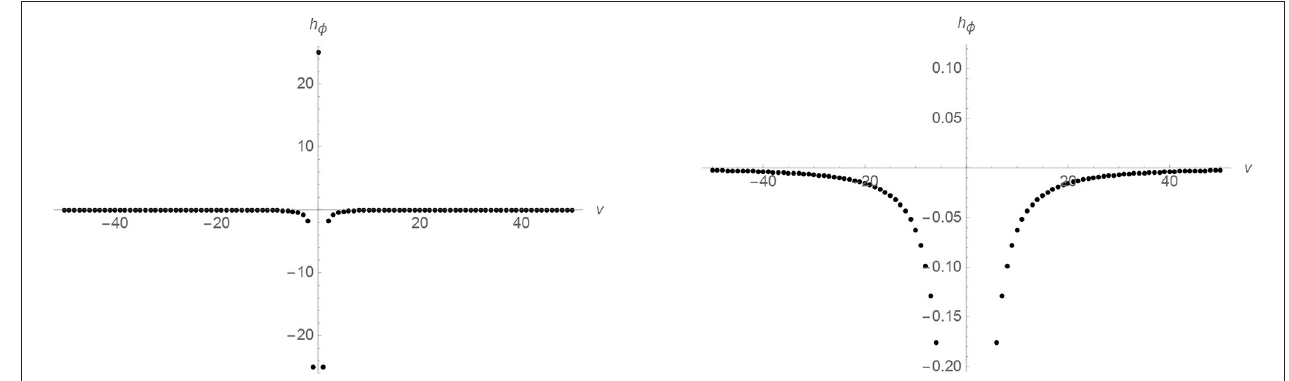
λ ) evaluated on an ǫ sector containing ν FIGURE 3 | The function h φ ( ν 0, for p φ 10 in natural units and λ 1 / 2 is plotted using two different ranges. On the left, ; = = = ν − 2 for large values of ν . This function can be seen as the effective potential we see that the function is finite near ν 0. On the right, we can see that it behaves like = − where an asymptotically free state of the universe (pure gravity with cosmological constant state or asymptotically de Sitter state) scatters. If the cosmological constant is negative there are bound states whose superposition can be used to define semiclassical universes oscillating in an endless series of big bangs and big crunches (see section